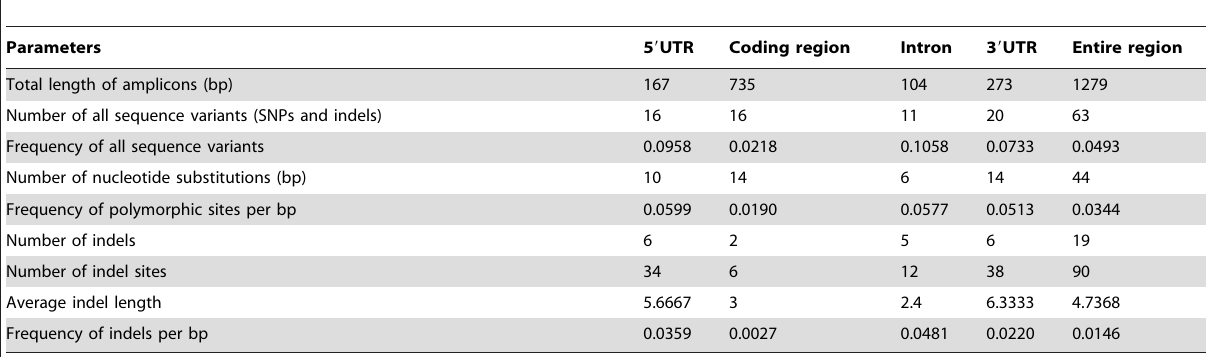
Table 2. Summary of the frequency of